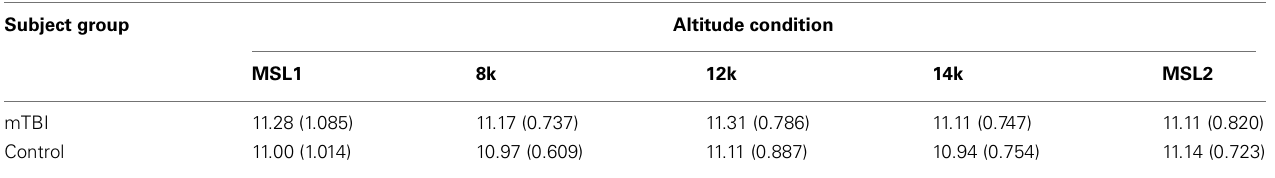
Table 2 | Mean (SD) duration in minutes of the BrainCheckers testing for each altitude.